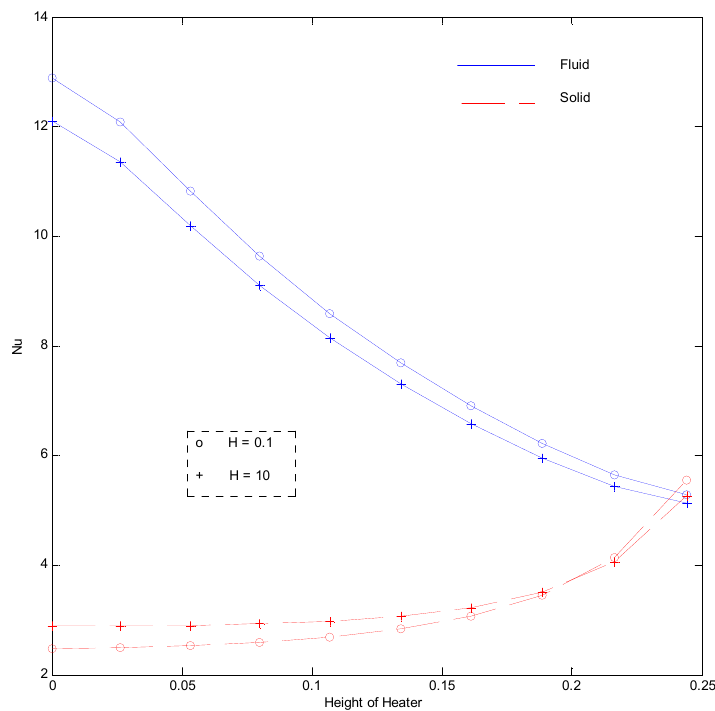
Mathematics 2019 , 7 , 1085 Figure 16. Nusselt number at Ra = 100 , HH = 25% , Kr = 1 , Rd=0 for strip at 5.0